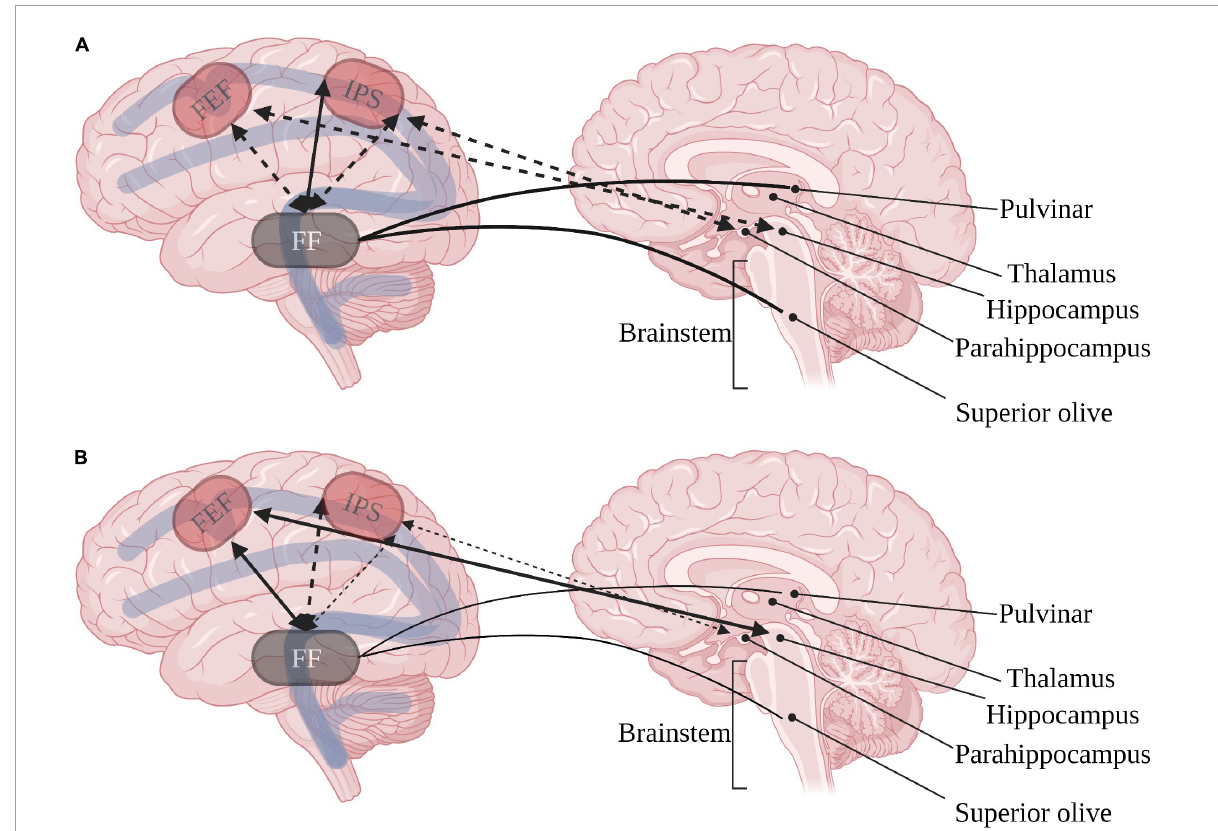
FIGURE1 Inter-relations between dorsal orienting (red) and arousal networks in (A) typical development and (B) ASD. Continuous arrows represent positive correlations, dashed arrows represent negative correlations. FEF, frontal eye field; IPS, intraparietal sulcus; FF, fusiform gyrus. Created with